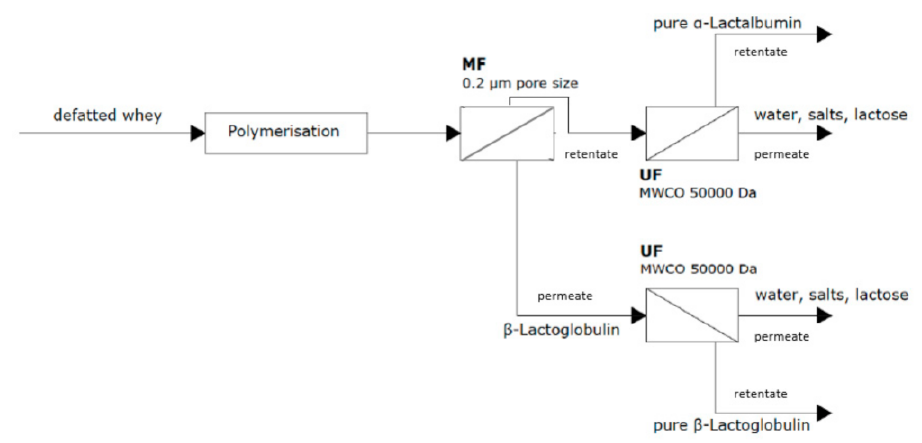
Figure 9. Membrane fractionation of whey protein to obtain β -Lactoglobulin and α -Lactalbumin by integration of MF and UF